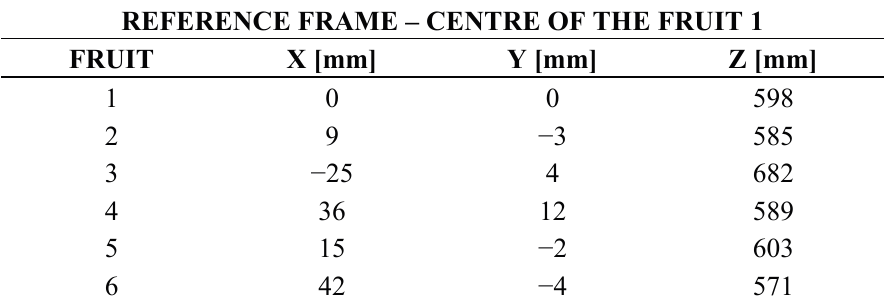
Table 2. Ground truth measurements for the scene presented in Figure 16.